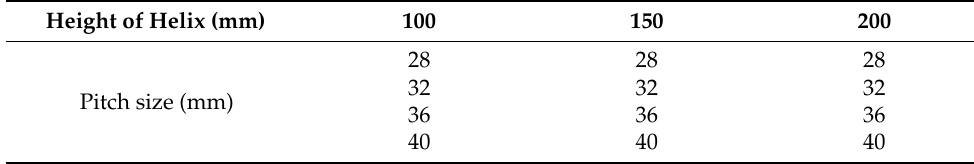
Table 1. Helicoidal seed tube dimensions subjected to laboratory tests.